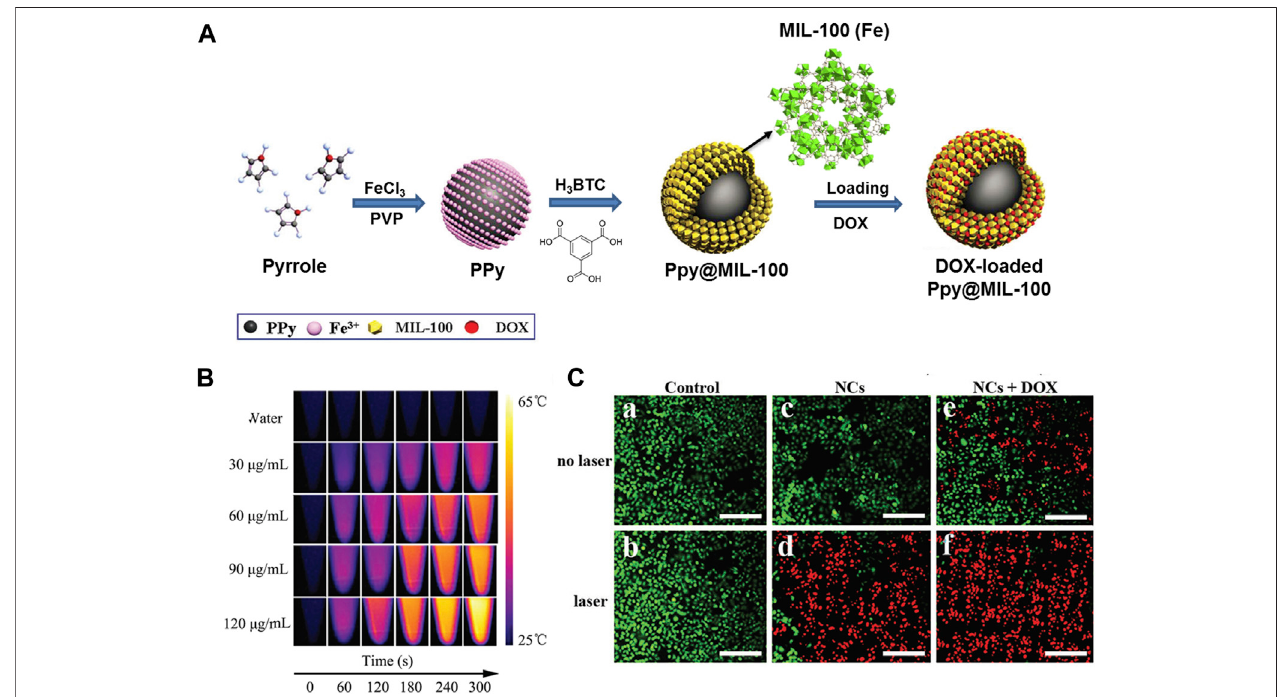
FIGURE 5 | (A) The schematic illustration of synthesis process of PPy@MIL-100(Fe). (B) Photothermal images of PPy@MIL-100(Fe) solution at different concentrations exposed to the 808 nm laser (2 W cm − 2 ) recorded at different time intervals (0, 1, 2, 3, 4 and 5 min). (C) Fluorescence images of HepG-2 cells with different treatments via staining with calcein AM/PI: a: control; b: laser irradiation only; c: PPy@MIL-100(Fe) NCs only; d: PPy@MIL-100(Fe) NCs with laser irradiation, e: DOX-loaded PPy@MIL-100(Fe) NCs only, f: DOX-loaded PPy@MIL-100(Fe) NCs with laser irradiation. Source: (Chen D et al., 2017).